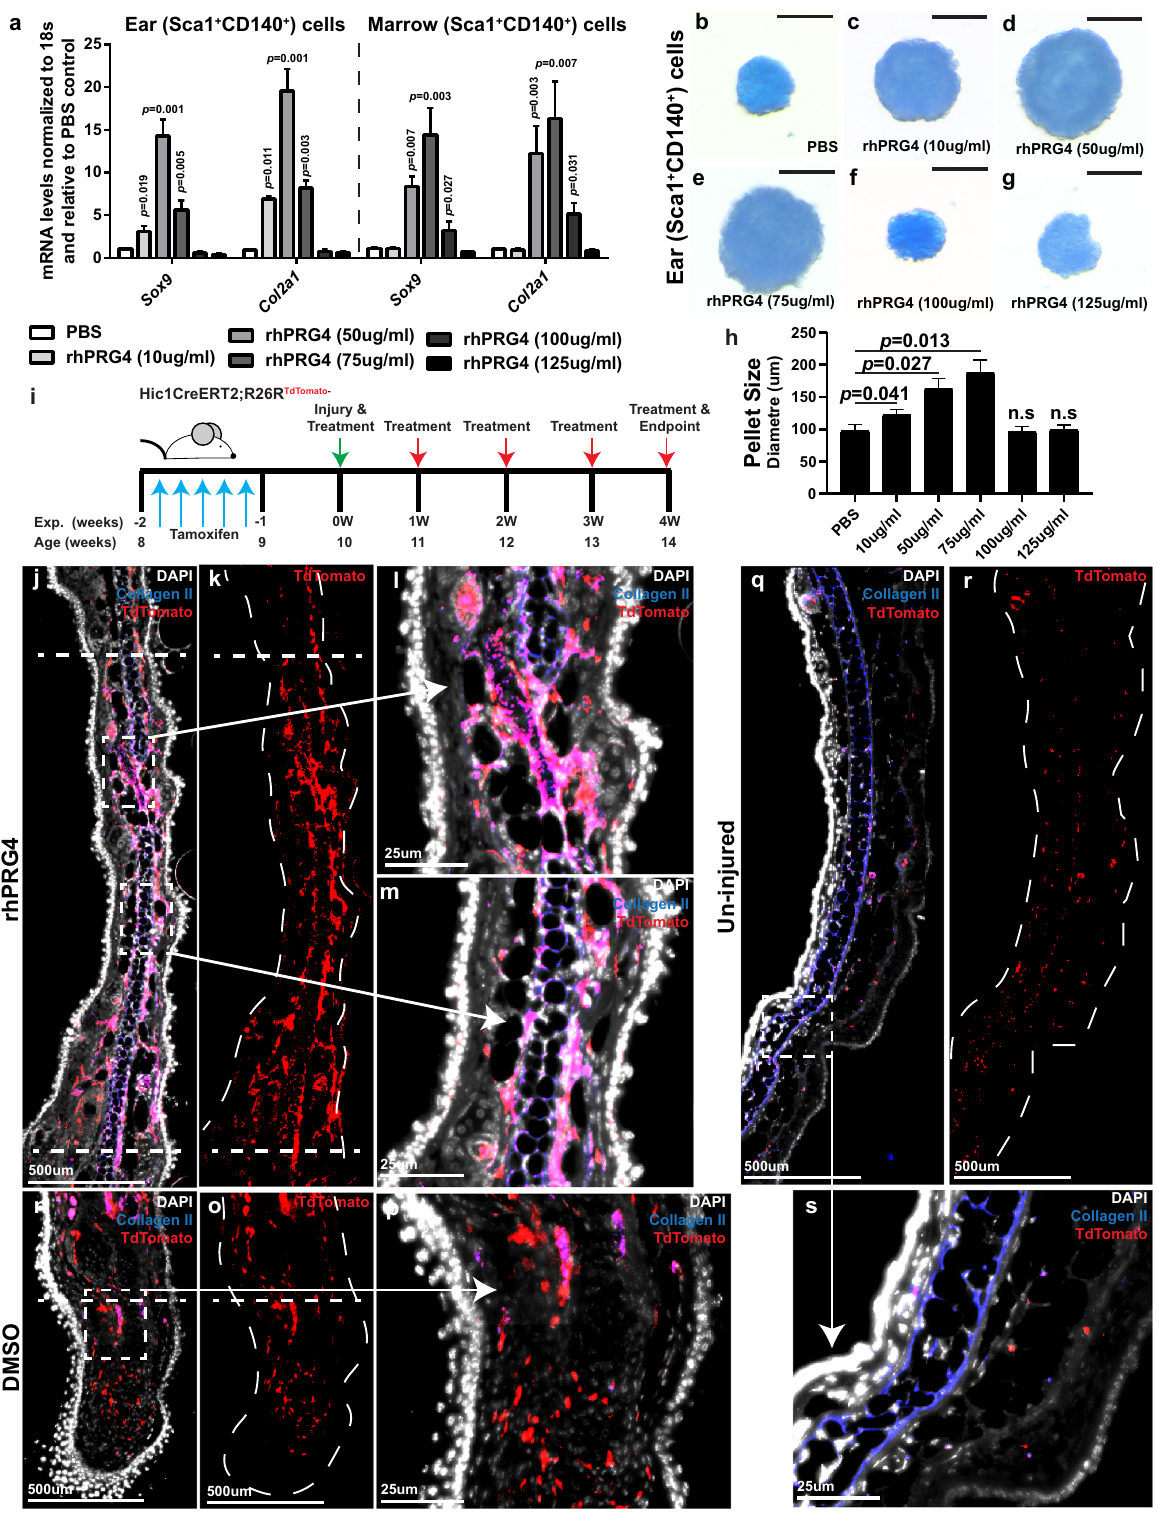
therefore, induce a similar outcome to that seen in Tlr4 − / − mice. Our current results show that Tlr4 − / − mice demonstrated enhanced wound healing, partly through regulation of VEGF, but also likely through modi fi cation of macrophage phenotype. However, this observation is not consistent with previous fi